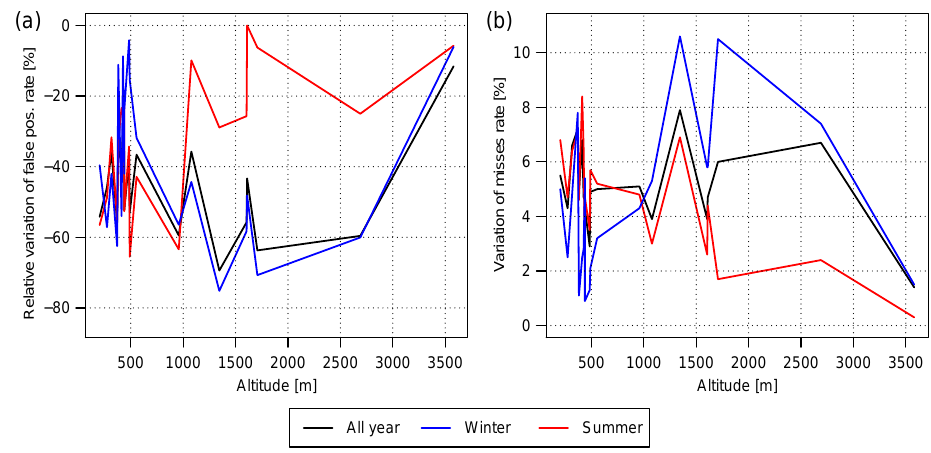
Figure 12. For each SYNOP station, a model was trained at all stations except one (leave-one-out validation). The figure shows the effect each model had on the rates of false positives ( a , relative percentages) and missing clouds ( b , absolute percentages) at the station left out, using SYNOP observations as a reference.